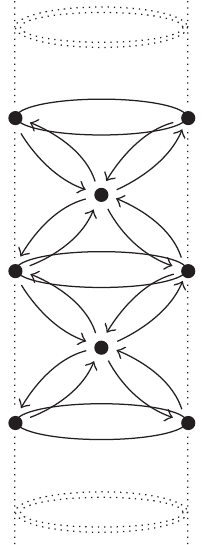
Figure 3: Sand-glass tube of rank (2,1)